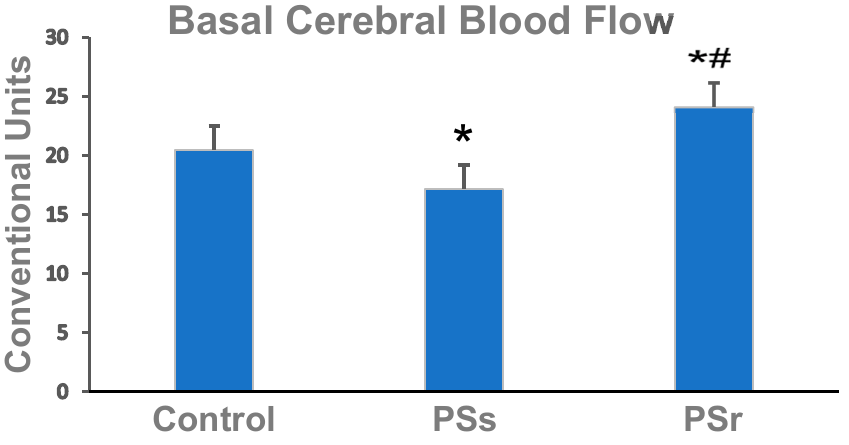
Figure 1. CBF in the parietal cortex of control, PSs, and PSr rats. CBF, cerebral blood flow; PSs, PS-susceptible rats; PSr, PS-resilient rats. * Difference from control, p < 0.040; # Difference from PSs, p = 0.043.